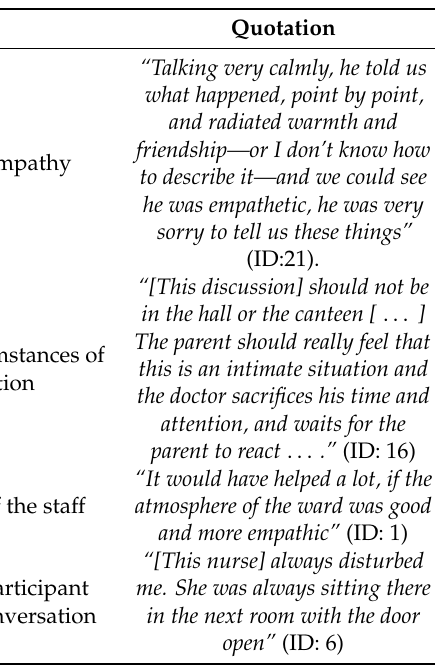
Table 6. Categories, examples, and quotations of Code 2.2 (nonverbal communication: positive: 2.2.1; and negative: